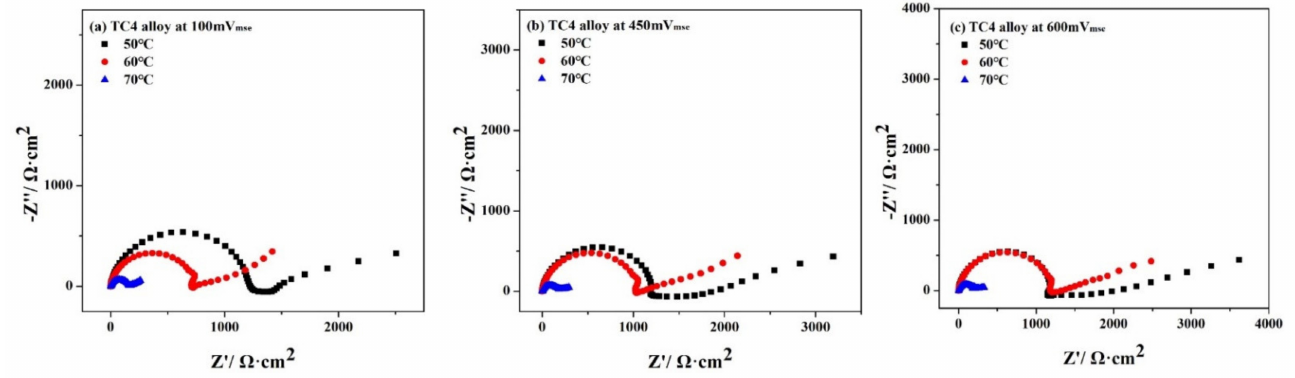
Figure 10. Nyquist plots for the TC4 alloy in 50 wt.% H 2 SO 4 at 100 mV mse ( a ), 450 mV mse ( b ) and 600 mV mse ( c